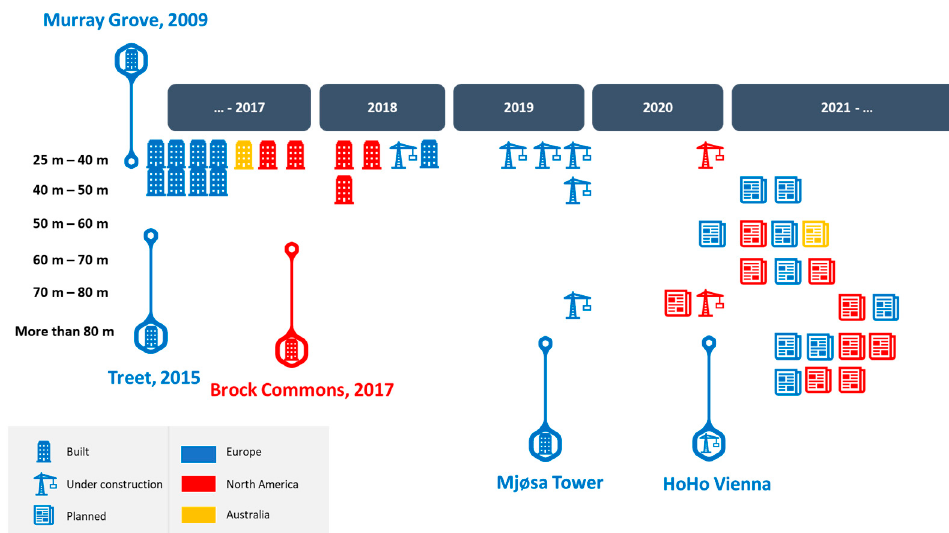
Figure 2. Tall timber buildings around the world—combined data [60–62].